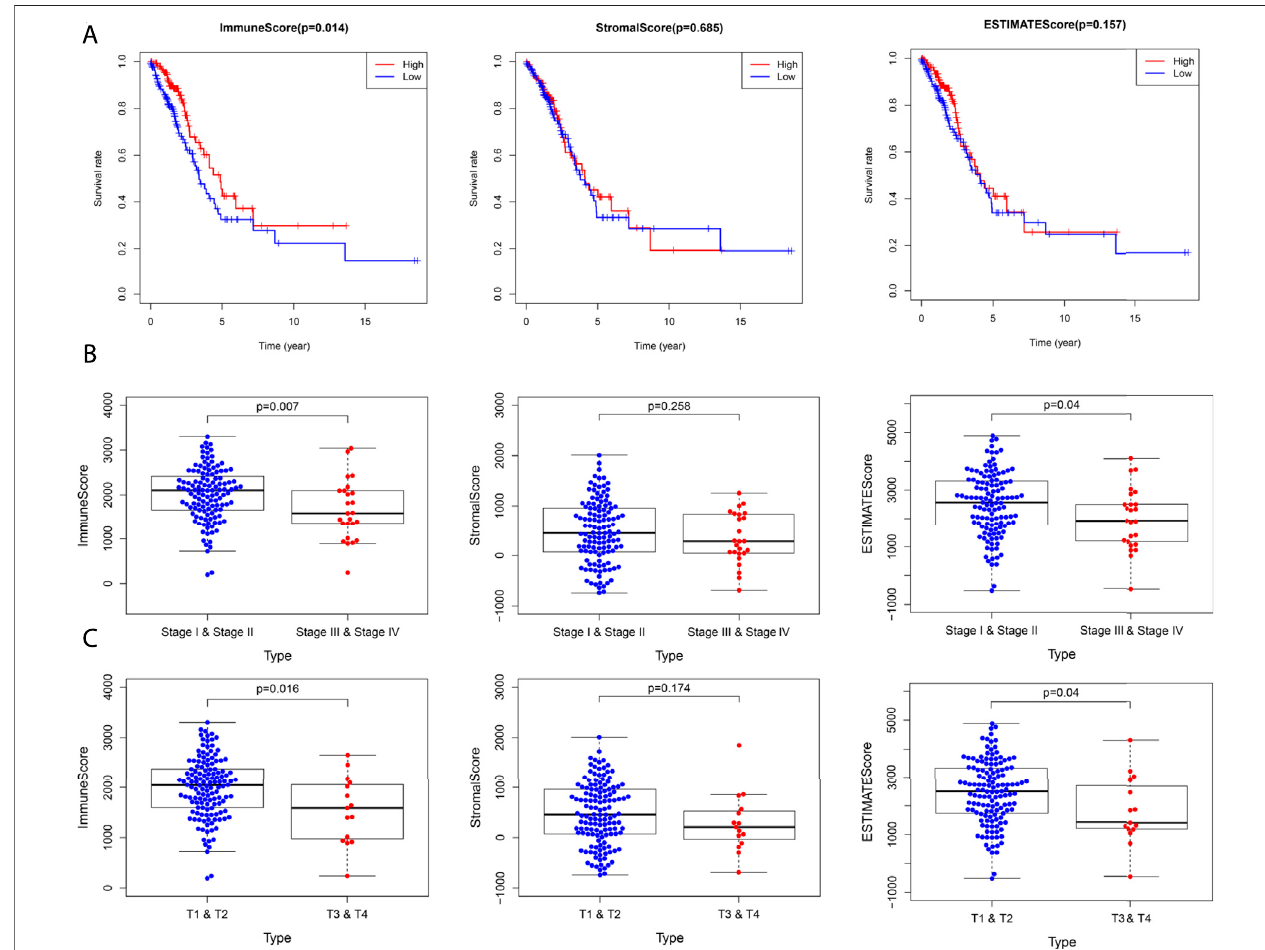
FIGURE 6 | (A) Correlation between survival and score in LUAD patients in the CCL17 high-expression group. (B) Stage classi fi cation of the CCL17 high- expression group. (C) T classi fi cation of the CCL17 high-expression group.